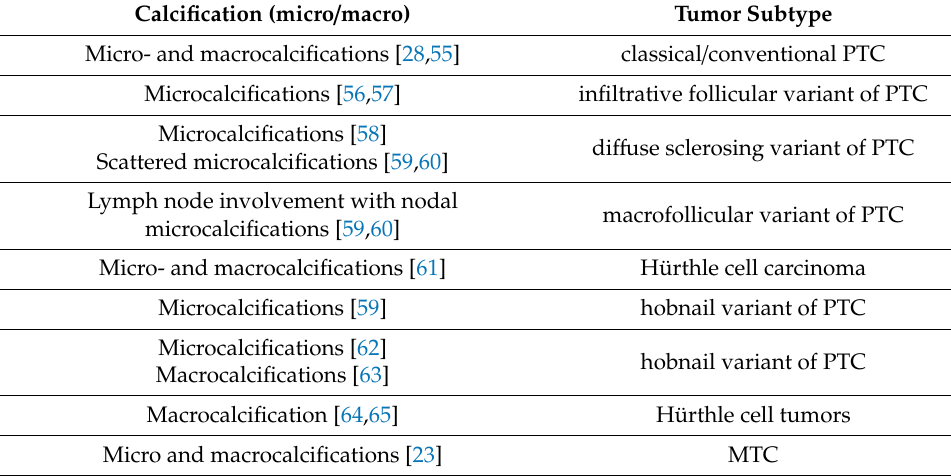
Table 2. Main types of calcification present in thyroid